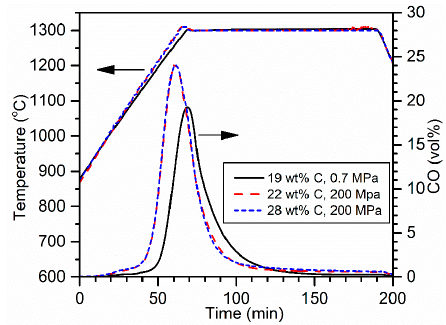
Figure 5. Temperature profiles and off-gas CO concentrations for the tests with the variation of graphite addition.